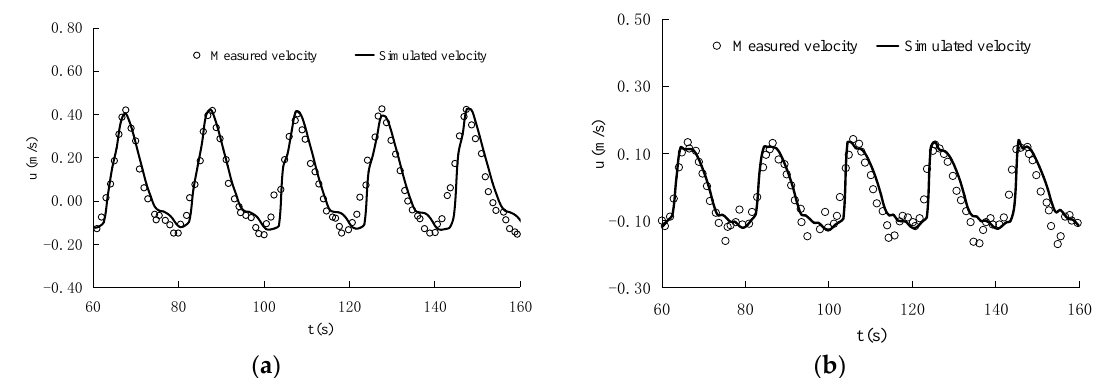
Figure 7. Time series of velocities, ( a ) at the center of the gap exit, ( b ) at the center of the end of the vegetation.